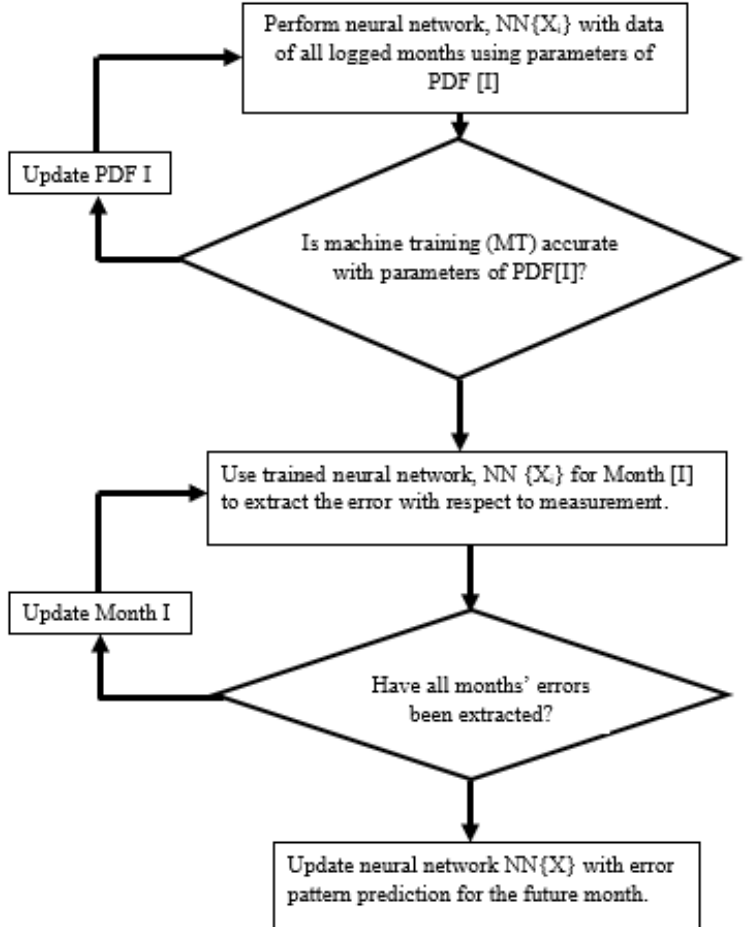
Figure 7. The analytic procedure of the proposed model.